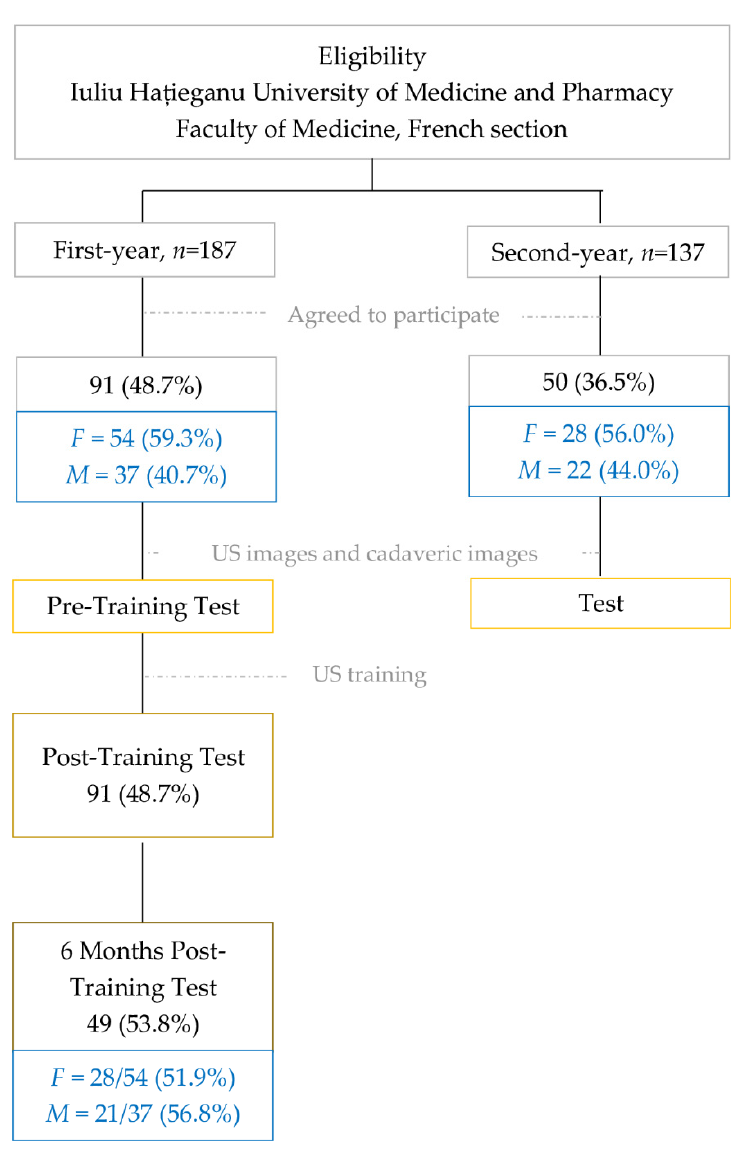
Figure 2. Study flowchart: from eligibility to analysis.